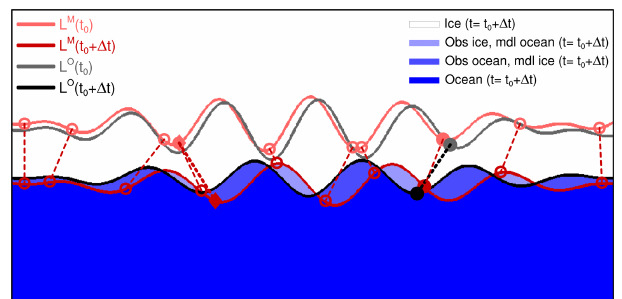
Figure 1. Binary fields with values of 1 (ice) and 0 (no ice/ocean) are displayed by white and blue color shading, respectively. Light shades of blue indicate regions with a non-overlapping ice cover, as indicated by the color legend. The derived modeled and observed ice edges L M and L O at t = t 0 + (cid:49)t are drawn as red and black curves, respectively. The corresponding ice edges that are taken to represent the situation at t 0 are drawn as light red and gray curves. The full black circle indicates the position on the observed ice edge at t 0 + (cid:49)t which has the largest distance to the ice edge at t 0 (the full gray circle). The largest displacement of the model ice edge is marked by full diamonds. The full red circle is the position along the model ice edge at t = t 0 + (cid:49)t closest to the full black circle, while the full light red circle is the position of the observed ice edge at t 0 closest to the full red circle. All dashed lines represent displacements as defined by Eq. (3). Open circles indicate a random selection of displacement positions for the model results; see the text for